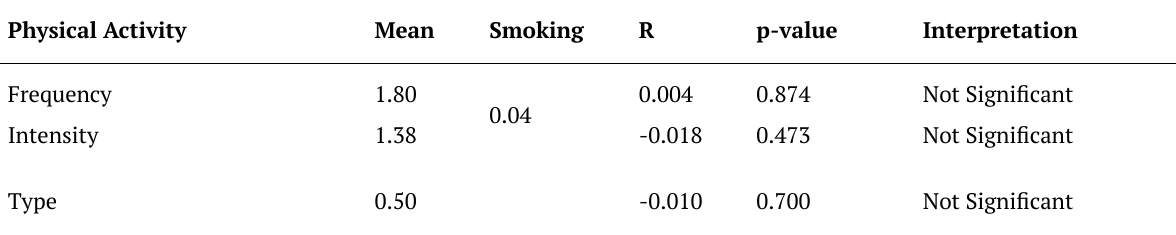
Table 4. Relationship between respondents’ physical activity and smoking habits Physical